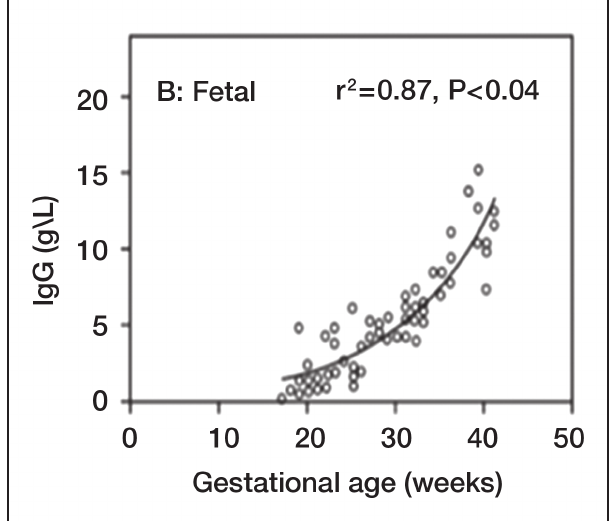
Figure 2) Immunoglobulin G (IgG) placental transport over